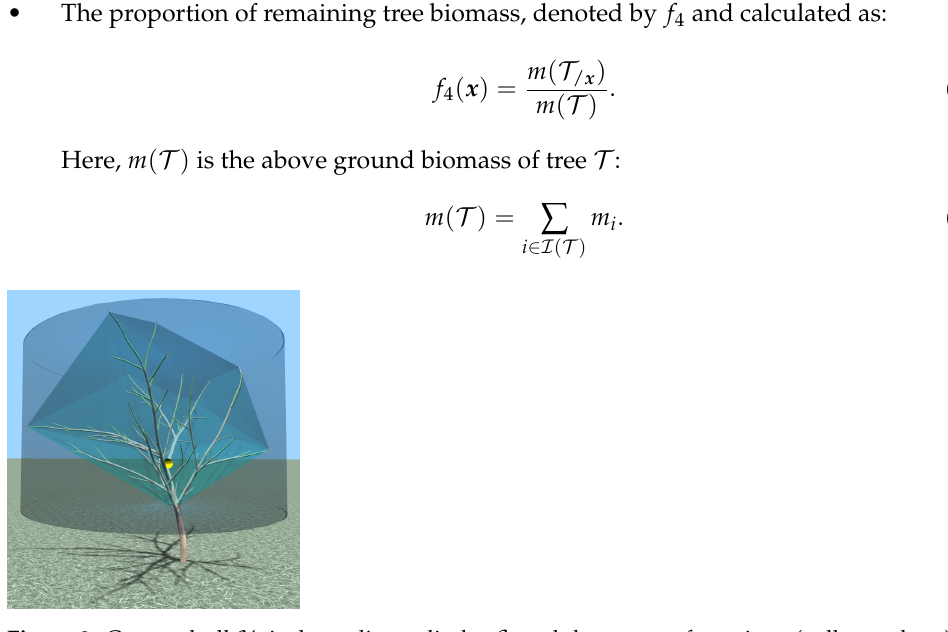
Figure 3. Convex hull a